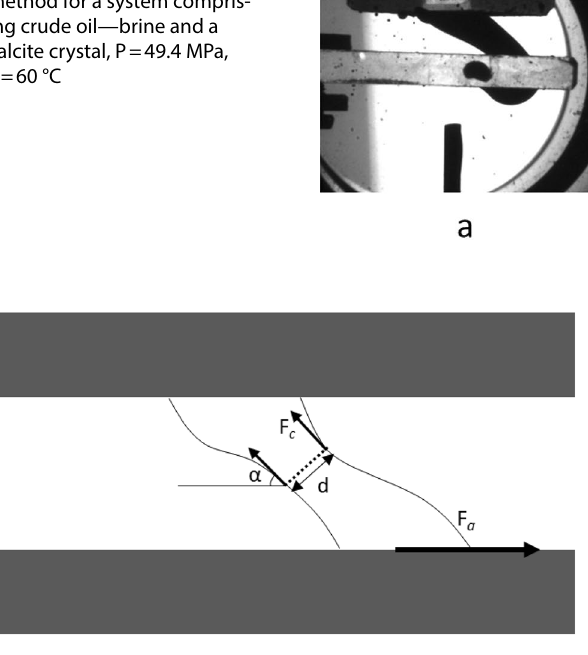
Fig. 8 Dual-drop dual-crystal method for a system compris- ing crude oil—brine and a calcite crystal, P = 49.4 MPa,